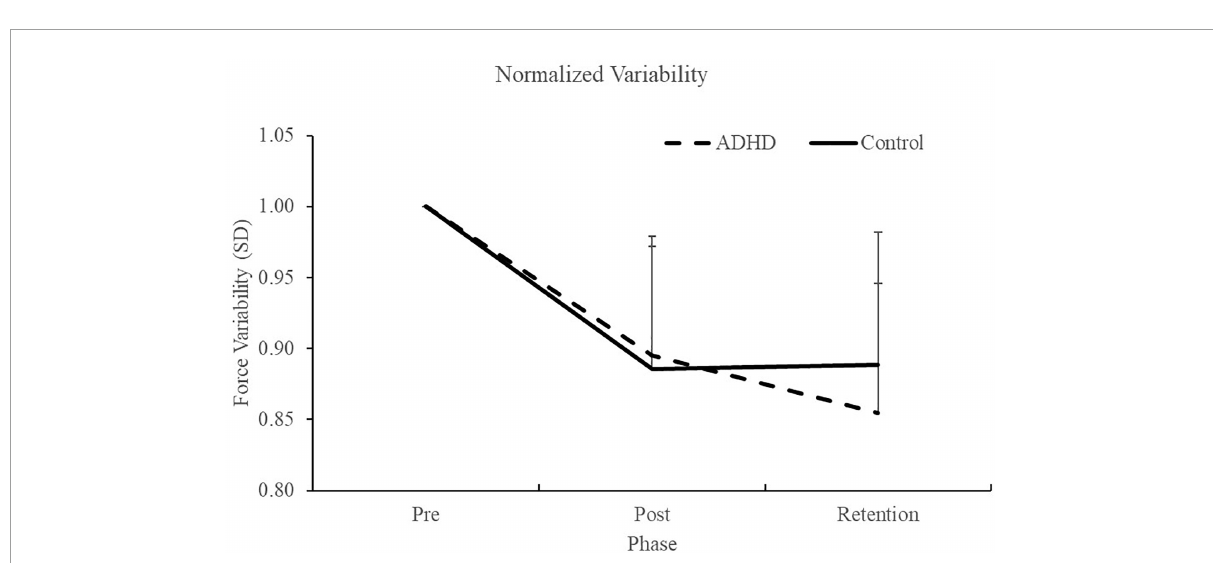
FIGURE5 Normalized force variability, when assessing SD, for each phase of the force-matching task (FMT). Variability is presented as SD of the force trace accuracy. Retention tests occurred 24–48 h after the pre and post data were collected. Values represent mean ±